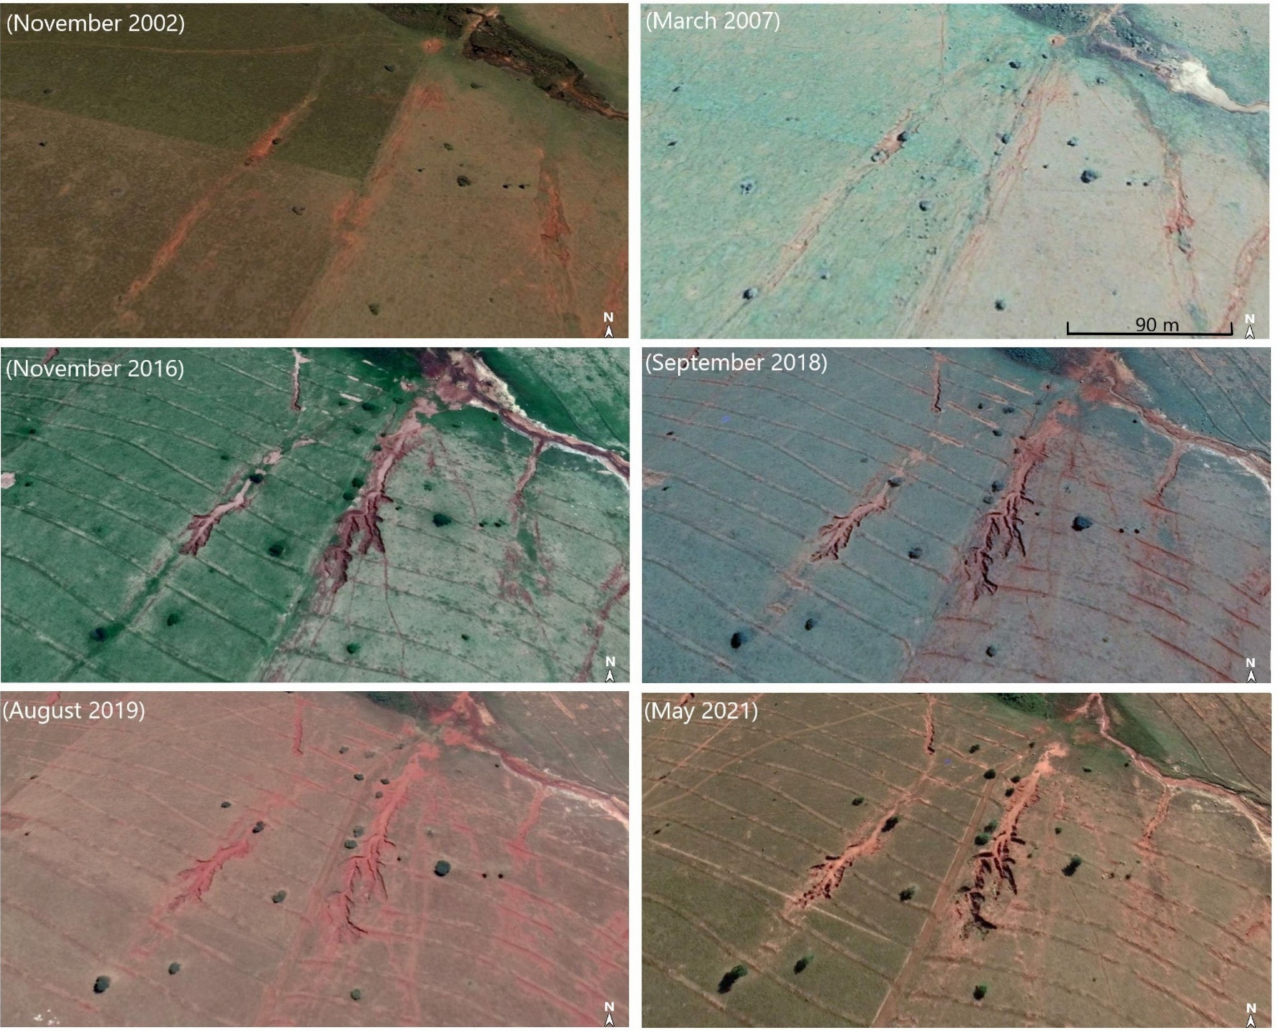
Figure 10. Evolution from an erosional rill to an erosional